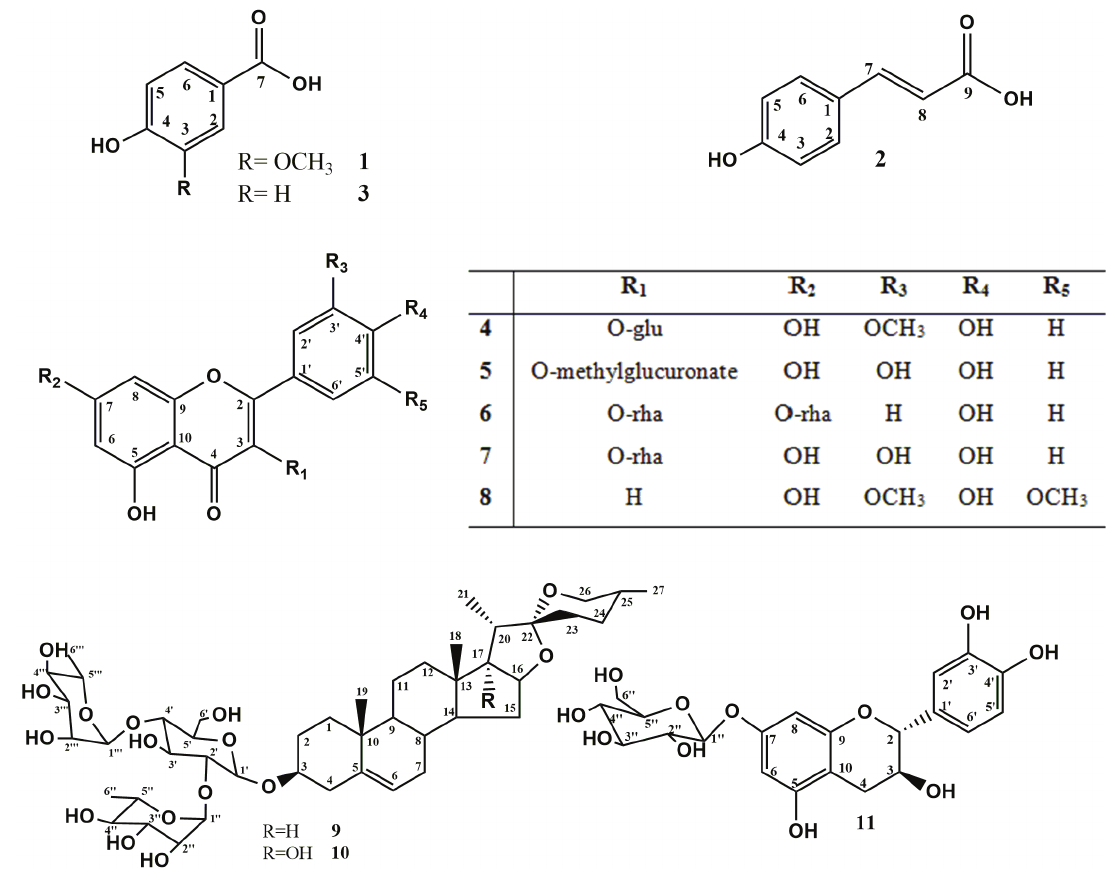
Figure 1 - Compounds identified in the extracts from Urochloa humidicola